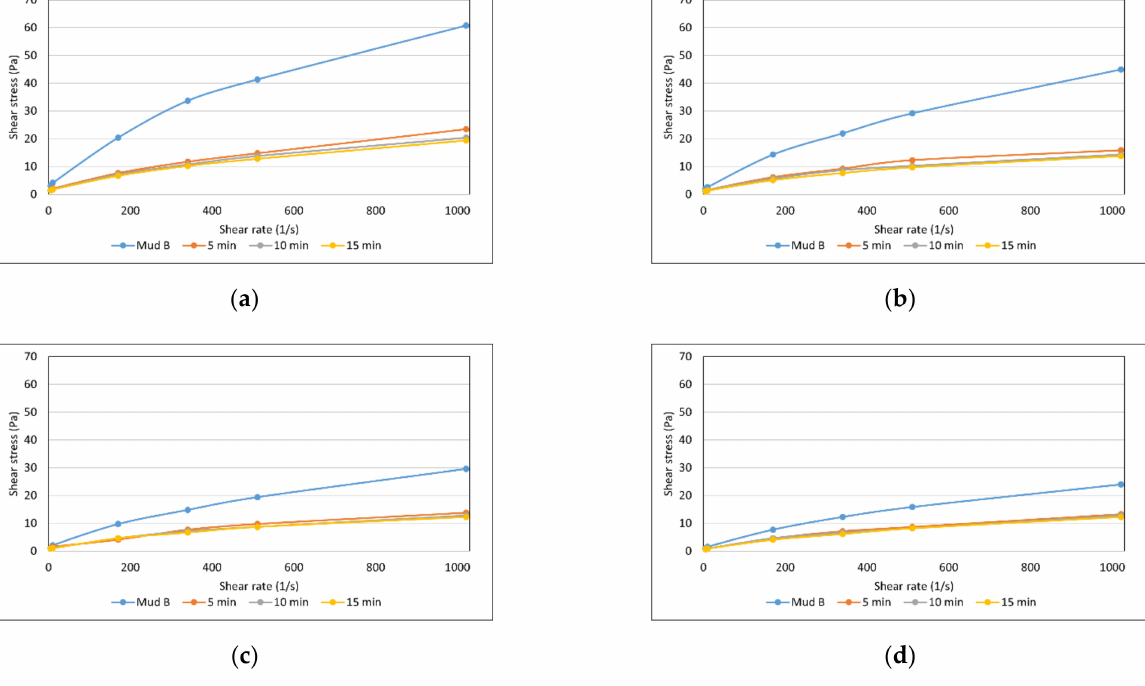
Figure 8. Flow curves of drilling mud B with the addition of 0.3% cellulase: ( a ) at 20 ◦ C, ( b ) at 40 ◦ C, ( c ) at 60 ◦ C, ( d ) at 80 ◦